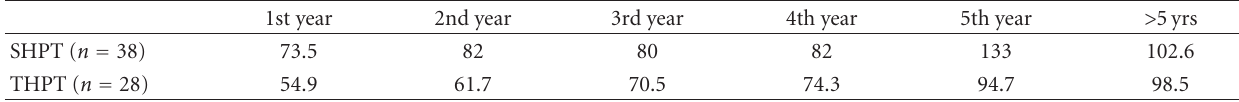
Table 2: Intact PTH (pg/mL) measurements in the followup.